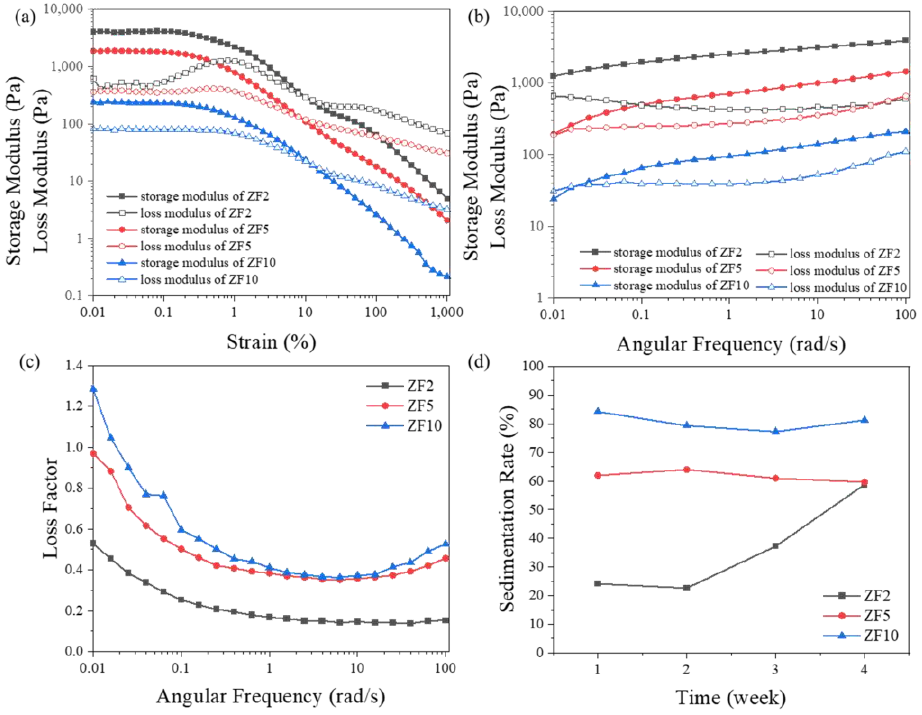
Figure 5. Effects of particle sizes on modulus under various ( a ) strains and ( b ) angular frequencies, ( c ) loss factor under angular frequency and ( d ) stability.